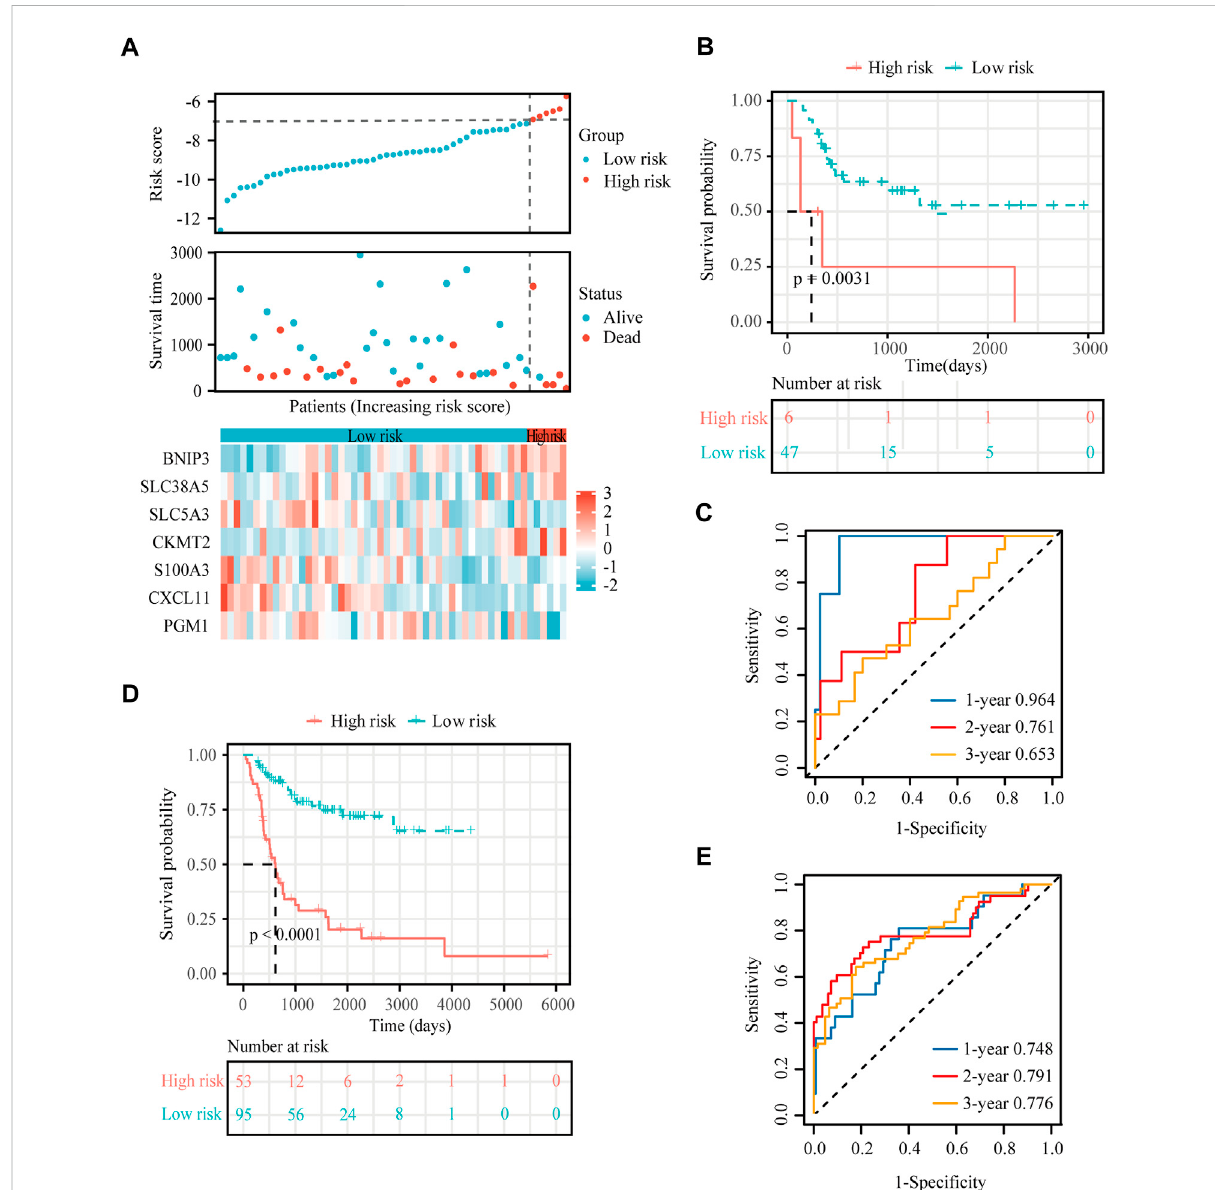
FIGURE 5 External veri fi cation for the hypoxia-immune-based prognostic signature. (A) Risk score, survival status and expression of the seven signature genes in the validation cohort from GSE21257 dataset. (B) K-M curve of overall survival for patients in the high-risk and low-risk groups in the validationcohortfromGSE21257dataset. (C) ROCcurvefor1-,2-,and3-yearoverallsurvivalinpatientsfromtheGSE21257dataset. (D) K-Mcurveof overallsurvivalforpatientsinthehigh-riskandlow-riskgroupsinthecombineddatasetforaggregatedanalysis. (E) ROCcurvefor1-,2-,and3- year overall survival in the combined